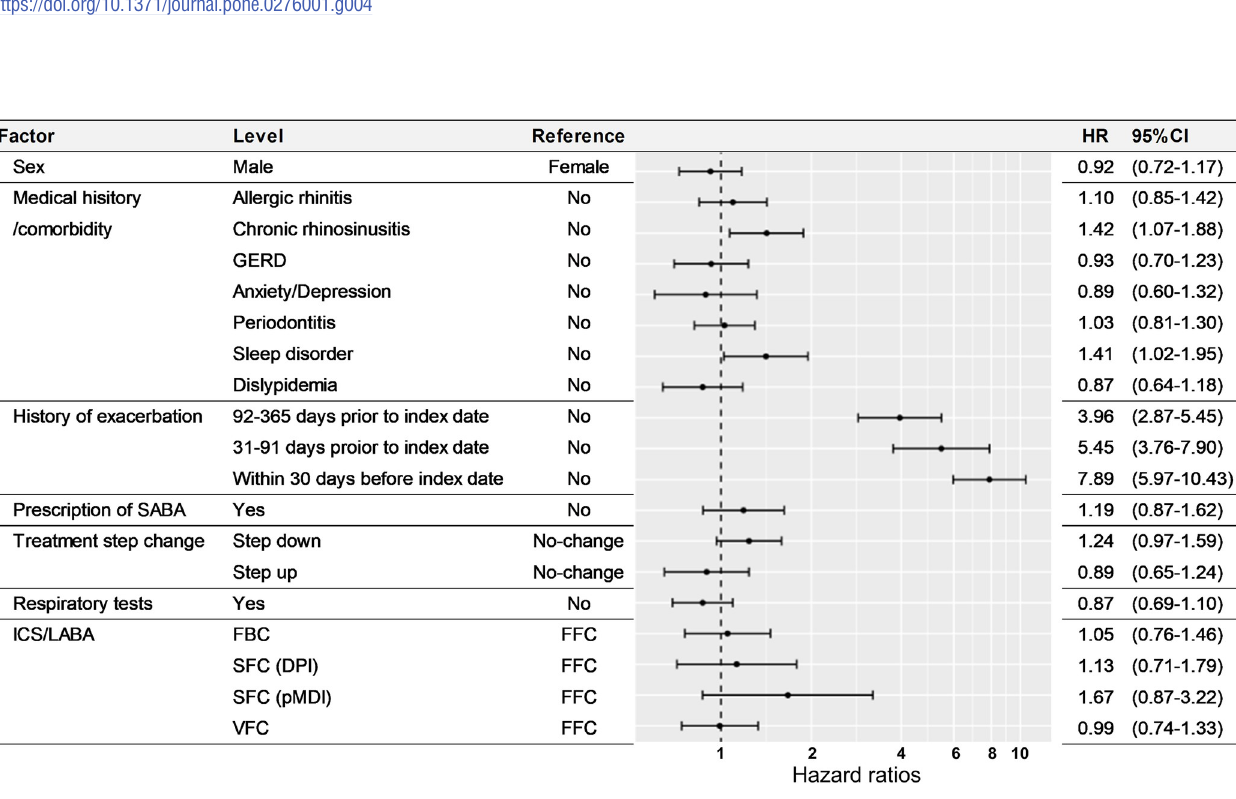
PLOS ONE | https://doi.org/10.1371/journal.pone.0276001 October 13,